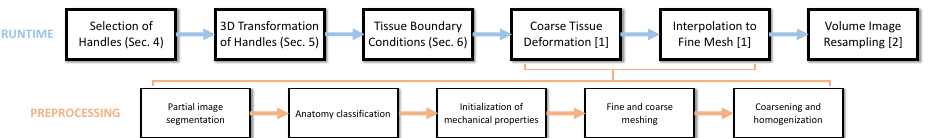
Figure 2. Runtime and preprocessing steps of our volume image manipulation method. At runtime, it combines novel interaction techniques with state-of-the-art volume image deformation techniques. A user selects handles within the volume, applies 3D transformations to the handles through 2D gestures, and the transformed handles translate into boundary conditions for an anatomy defor- mation model. We use the corotational coarsening method to deform the volume image [1], which entails three steps: low-resolution deformation, interpolation of this deformation to a high-resolution mesh, and resampling of the volume image [2]. In addition, the volume image deformation approach requires several preprocessing steps for the generation of a highly accurate low-resolution interactive model: partial segmentation of the volume image, classification of the anatomy elements based on im- age values, initialization of mechanical properties from image values, high-res and low-res meshing, and coarsening from the high-res deformation model to a homogenized low-res deformation